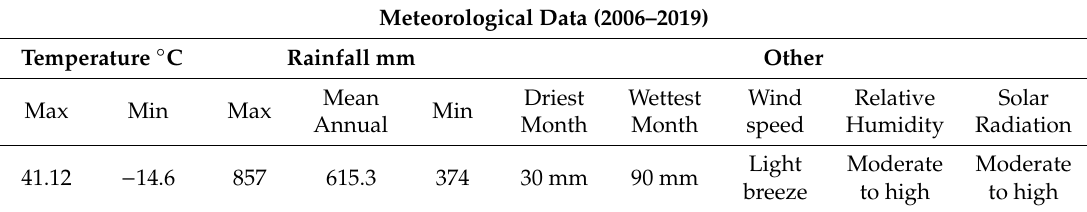
Table 1. Overview of the qualitative and quantitative information regarding the meteorological observations .